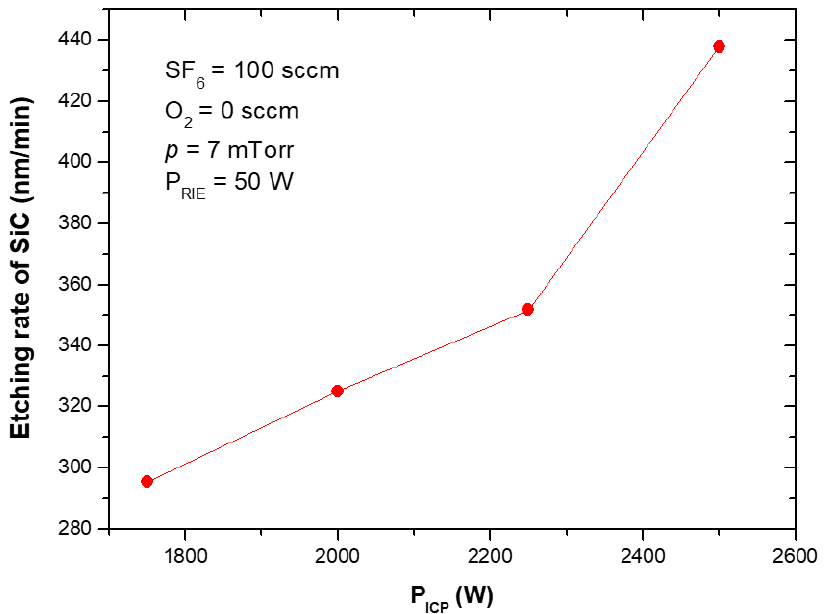
Figure 15. SiC etching rate as a function of ICP power applied. Fixed parameters are included in the inset.